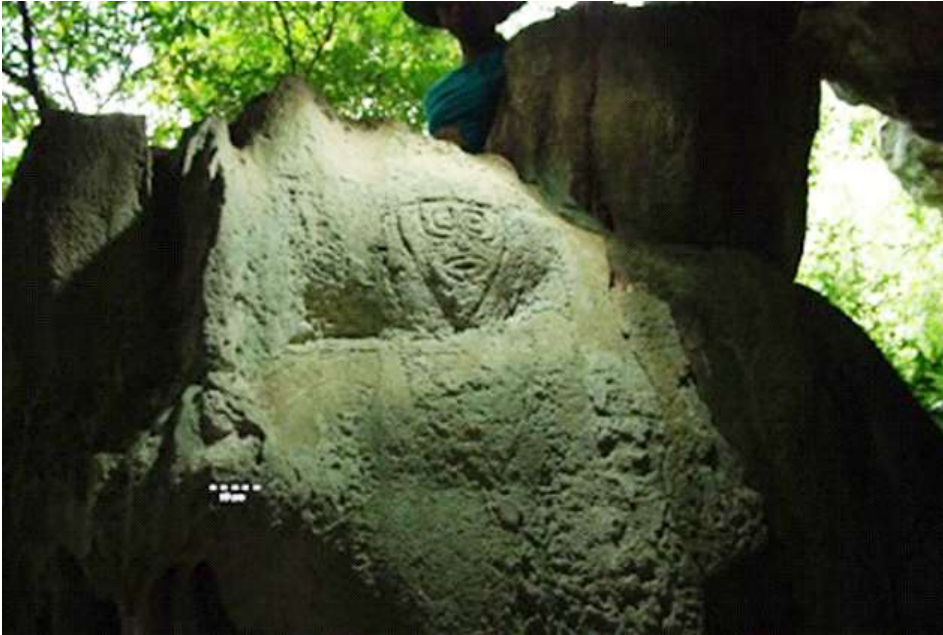
Figure 12. The stone faces of Lene Hara cave in East Timor, a cave also known for painted rock art. Photo: Sue